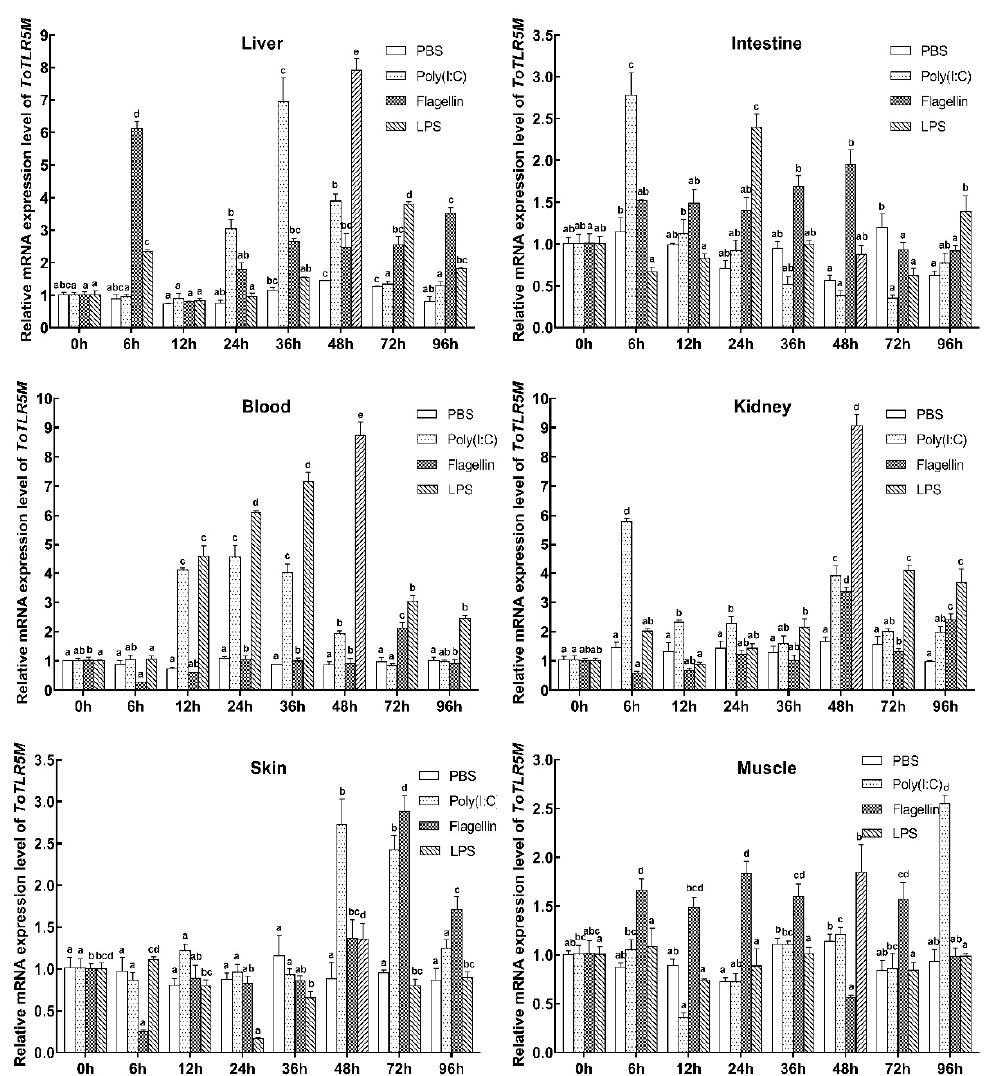
Figure 4. ToTLR5M expressions in different tissues (liver, kidney, intestine, skin, muscle, and blood) after phosphate-buffered saline (PBS), flagellin, poly(I:C), and LPS challenge. EF-1 α acted as an internal control to calibrate the cDNA templates. All data are expressed as mean ± SE. Different letters show significant differences ( p < 0.05).